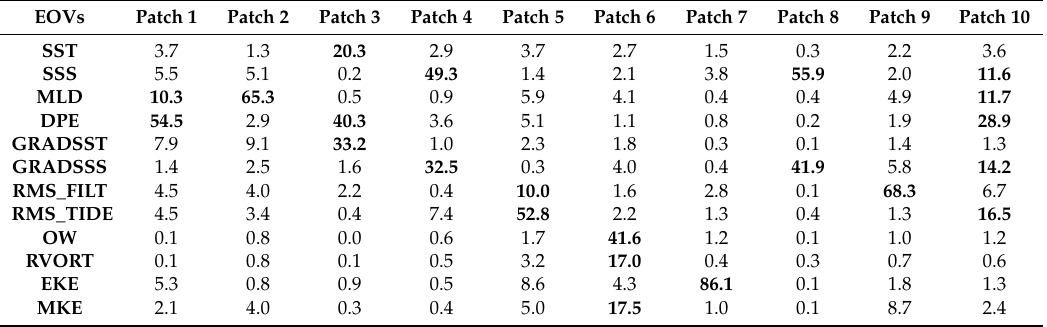
Table 2. Rank of the individual variables based on their relative influence in each Generalized Boosted Regression Modeling (GBM) model. Dominant variables are written in